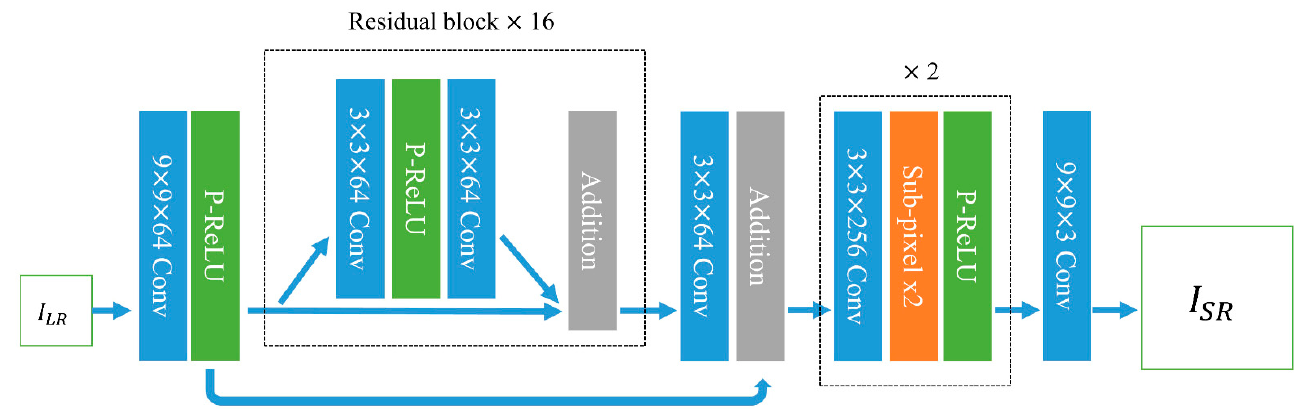
Figure 1. The architecture of the non-generative adversarial network (GAN)-based models. Note that the stride of 1 is applied to all convolutional layers.